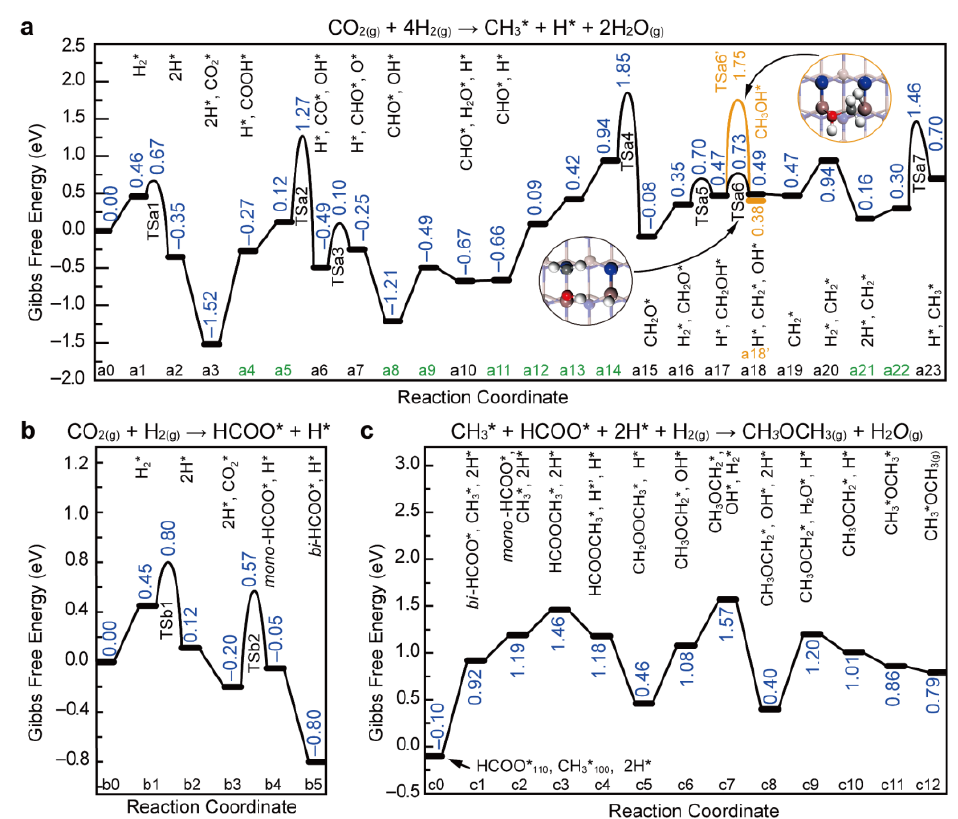
Figure 9. The density functional theory calculation results of CO 2 hydrogenation over GaN. ( a ) Gibbs free energy diagram of the CO 2 hydrogenation to methyl (CH 3 * ) on the GaN(100) plane. ( b ) Gibbs free energy diagram of the CO 2 hydrogenation to formate (HCOO * ) on the GaN(110) plane. ( c ) Gibbs free energy diagram for the coupling of HCOO * and CH 3 * to CH 3 OCH 3 * on the (110)/(100) interface. TS: transition states. Reproduced with permission from Liu et al. [33], published by Springer Nature, 2021.